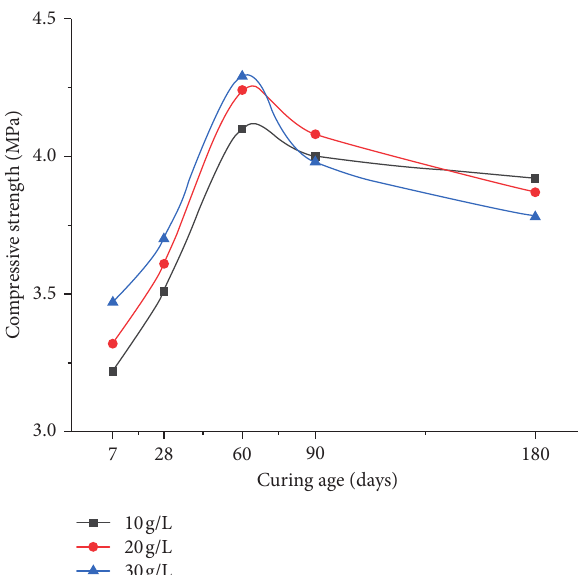
Figure 2: Compressive strength of 7% scheme in different